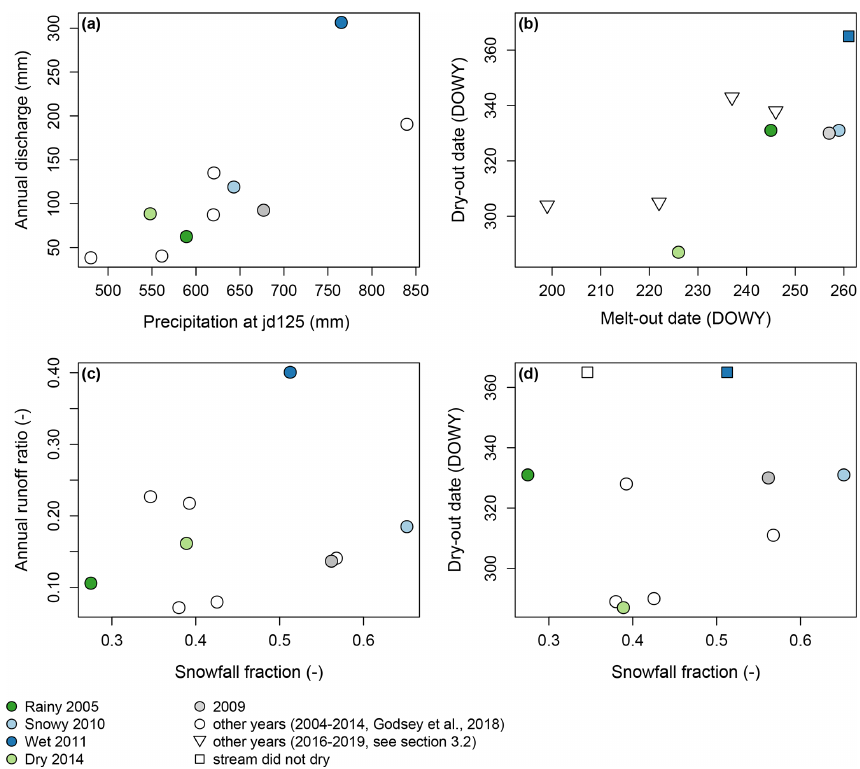
Figure 6. Scatterplots of (a) annual discharge at the catchment outlet (mm) and annual precipitation at the lowest precipitation gauge (jd125, mm; see Fig. S14 in the Supplement for a comparison with simulated mean catchment precipitation), (b) the day that surface flow in the stream ceased (dry-out date, shown as day of water year – DOWY) and the day on which all snow had melted (melt-out date, DOWY), (c) the annual runoff ratio (annual discharge/annual precipitation at jd125) and the annual snowfall fraction (–), and (d) the stream dry-out date and the annual snowfall fraction. Years in which the stream did not dry out are projected to the last day of the hydrological year. The r 2 and p values for linear regressions between the variables in each panel are (a) r 2 = 0 . 83 and p value = 0 . 001, (b) r 2 = 0 . 74 and p value = 0 . 023, (c) r 2 = 0 . 23 and p value = 0 . 524, and (d) r 2 = 0 . 12 and p value = 0 .